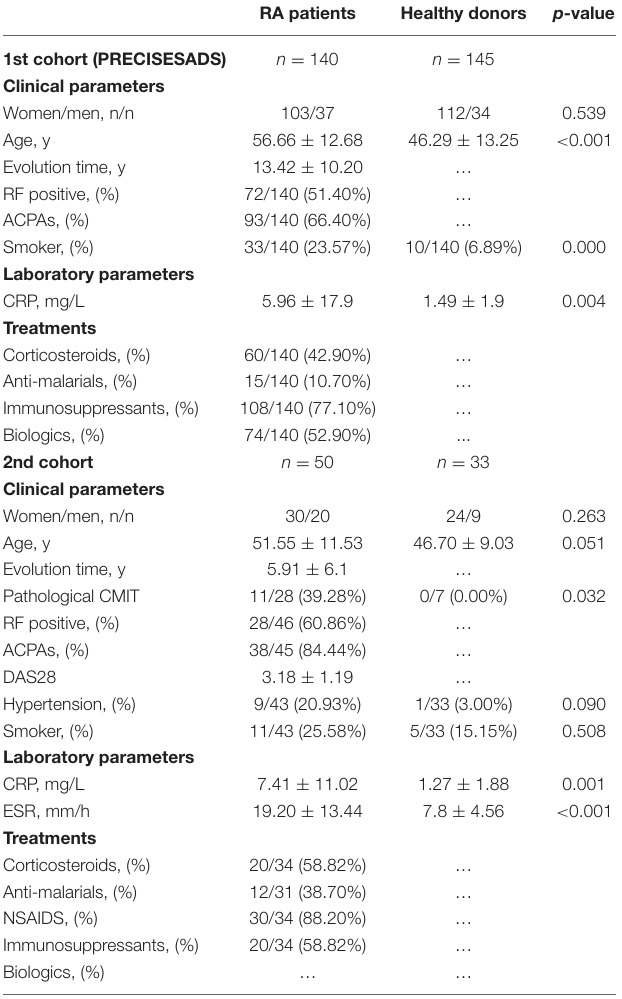
TABLE 1 | Clinical details of the Rheumatoid Arthritis patients and healthy donors. RA